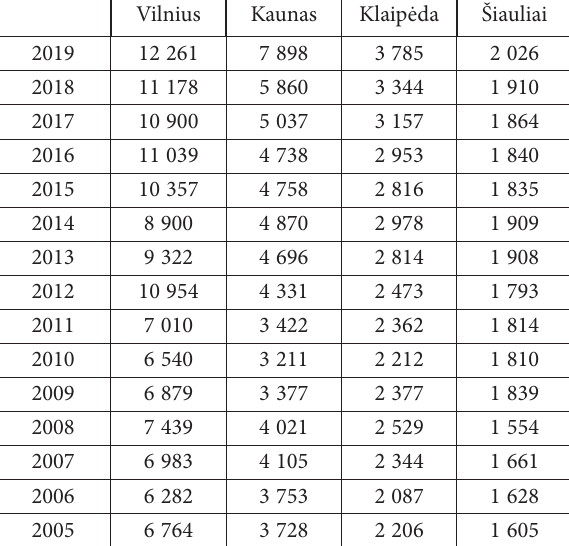
Table A1. Number of newcomers to a certain Lithuanian city from other locations in 2005−2019